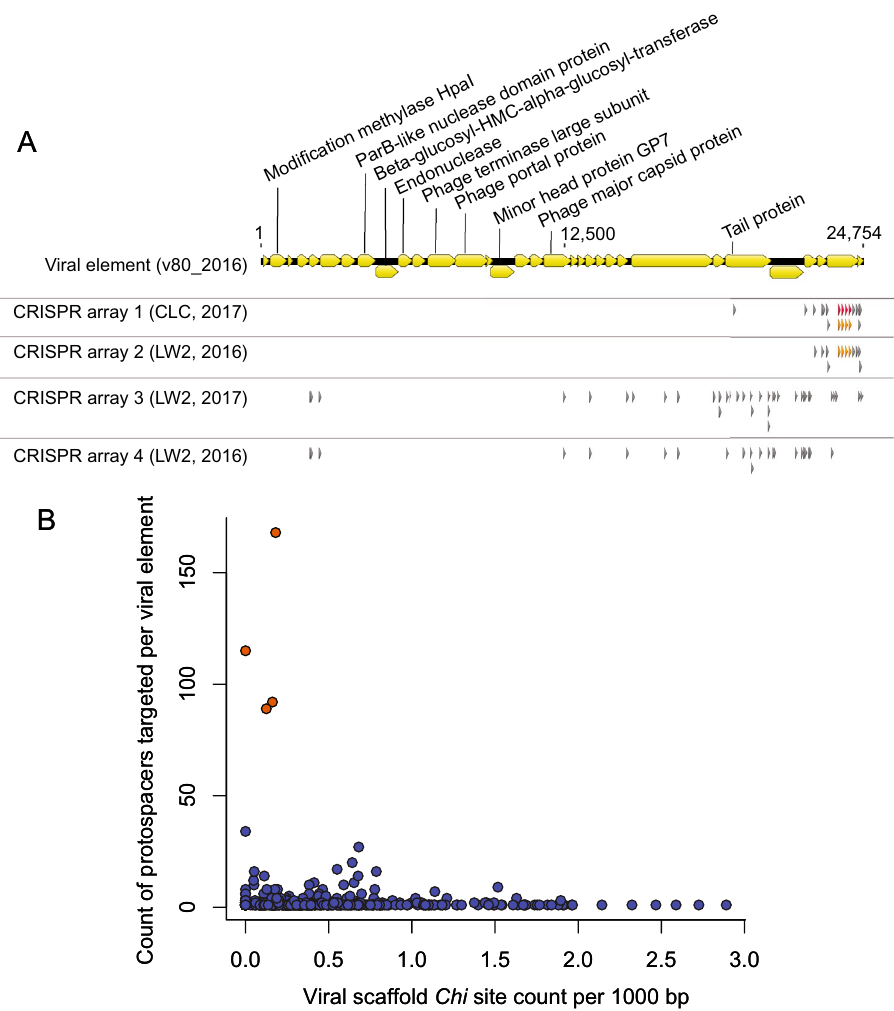
Figure 2. ( A ) Genetic features targeted by host CRISPR arrays on a hyper-targeted viral element. The coding sequences’ annotations for one hyper-targeted viral element (V80_2016) with corresponding CRISPR spacer mappings are displayed. In the targeting profile of a single host scaffold, a non-grey triangle represents a single spacer that had multiple matches to regions of the viral element. When shared, these single spacers are colored the same between distinct host targeting profiles. CRISPR spacer mapping and visualization was conducted using Geneious 60 . Host scaffold accessions are as follows: CRISPR array 1: Ga0265294_10000314; CRISPR array 2: Ga0172382_10051677; CRISPR array 3: Ga0265293_10000924; CRISPR array 4: Ga0172382_10020296 & Ga0172382_10071763 (two arrays within one host MAG, only one is responsible for hyper-targeting). ( B ) Chi site counts in viral elements (in Chi site per 1000 bp) compared to number of times a viral scaffold was targeted by a host across all virus-host networks. Hyper-targeted viral elements are highlighted in orange.